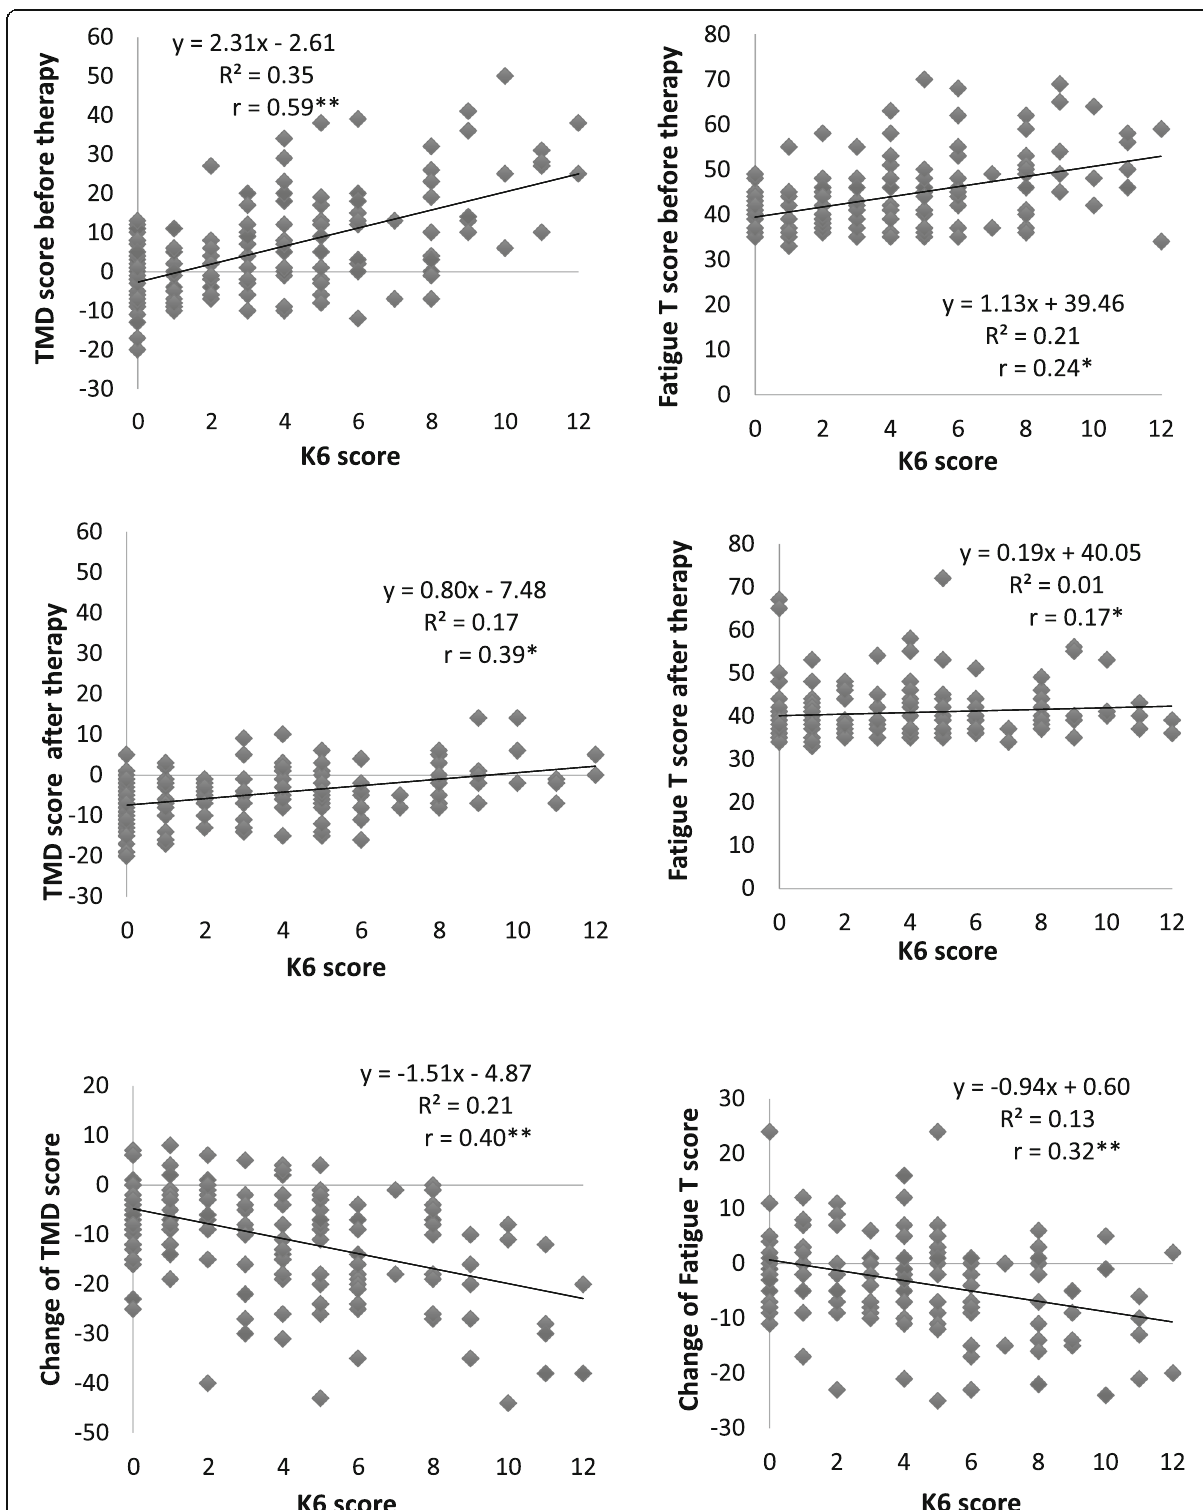
Fig. 3 Correlation coefficient between K6 and TMD score, fatigue T score (POMS subscale). * p < 0.05, ** p < 0.01, Spearman ’ s rank correlation co- efficient, and their changes before and after forest